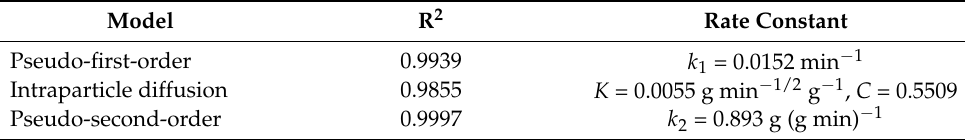
Table 2. Correlation coefficients and rate constants for the HS–BB 3 reaction. Model R 2 Rate Constant Pseudo-first-order